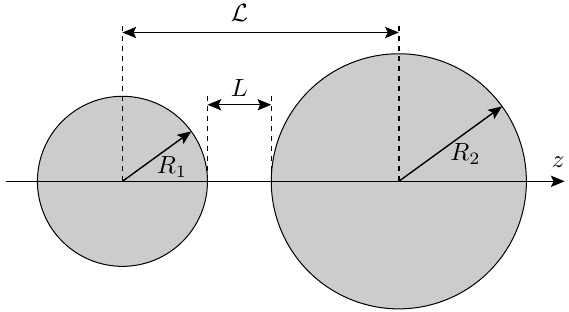
Figure 1: Representation of the geometry with two spheres of radii R distance between the spheres is given by L and sphere